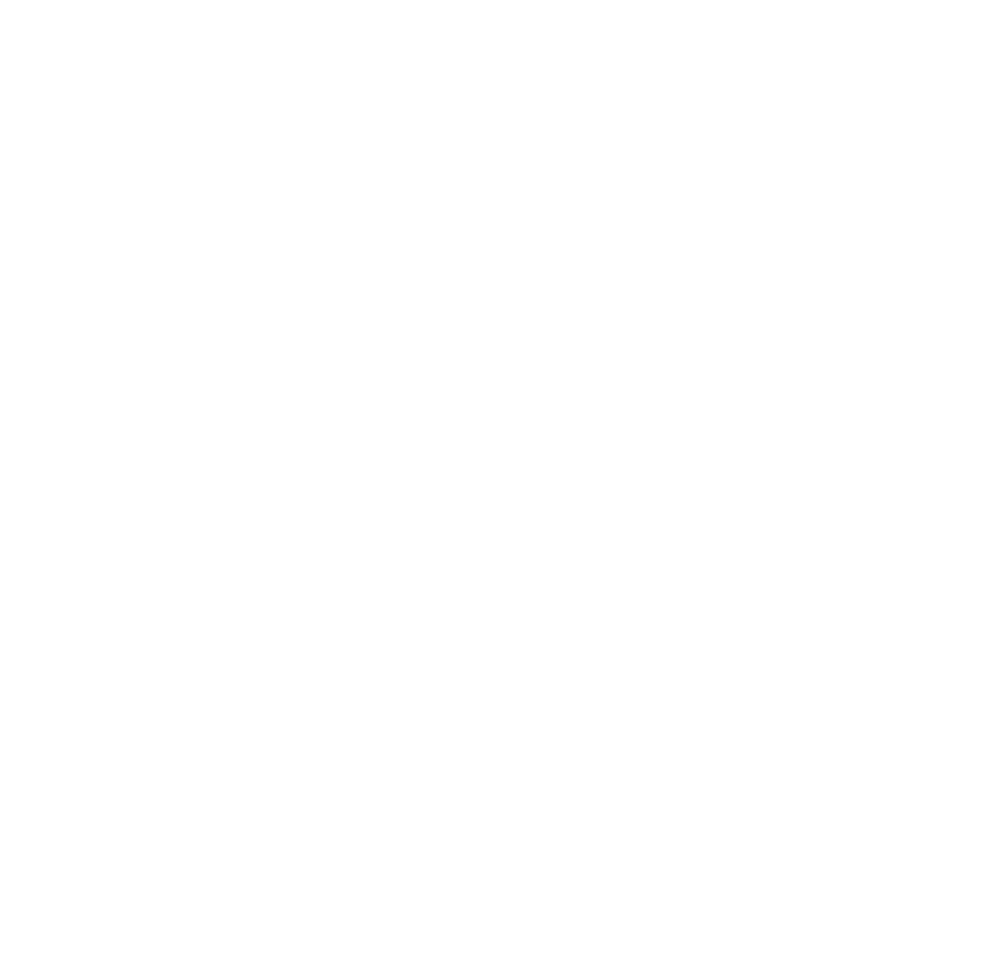
Figure A3 | Partial results of segment analysis of tuft dendrites of TTL5 neurons. (A) Average segment diameter versus branch order. The curves at different ages have the same shape and largely overlap each other. (B1–B2) Average segment length of intermediate and terminal segments versus branch